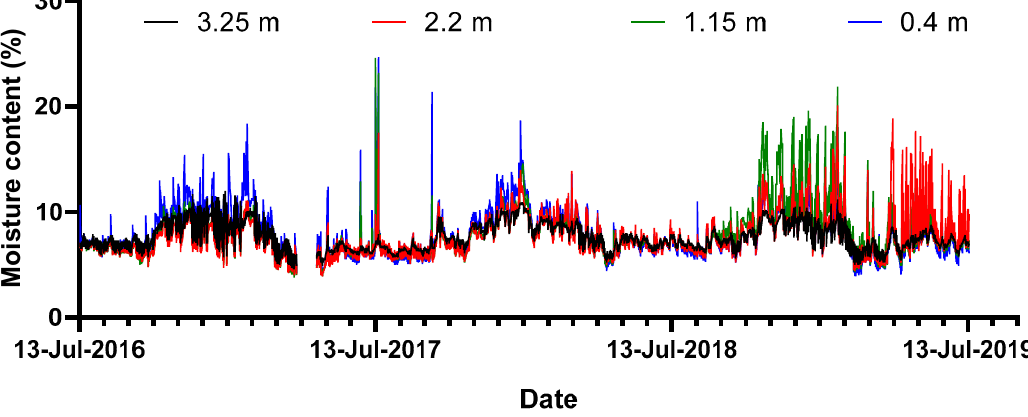
Figure 7. Influence of the distance from the ground on the wood moisture content of the façade on the monitored Annex of the Wood Science and Technology building in Ljubljana in the period between 13th of July 2016 and 15th of July 2019.